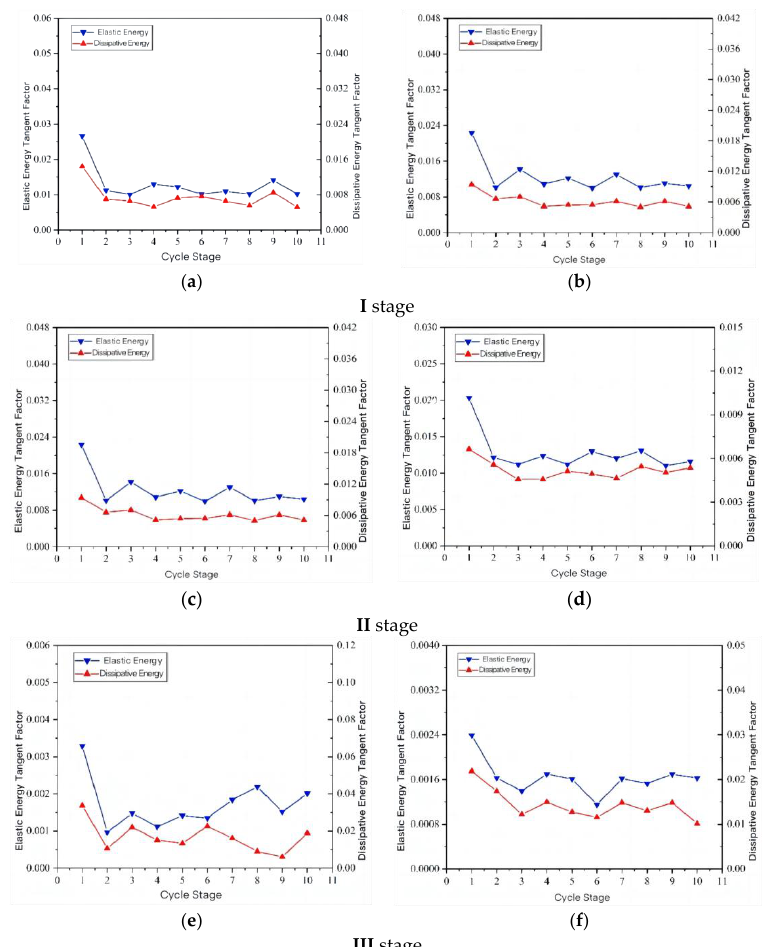
Figure 10. The energy tangent factor under equal amplitude cyclic loading/unloading. ( a ) Elastic energy tangent factor and dissipative energy tangent factor of coal sample S3 in stage I. ( b ) Result of coal sample S4 in stage I. ( c ) Result of coal sample S3 in stage II. ( d ) Result of coal sample S4 in stage II. ( e ) Result of coal sample S3 in stage III. ( f ) Result of coal sample S4 in stage III.